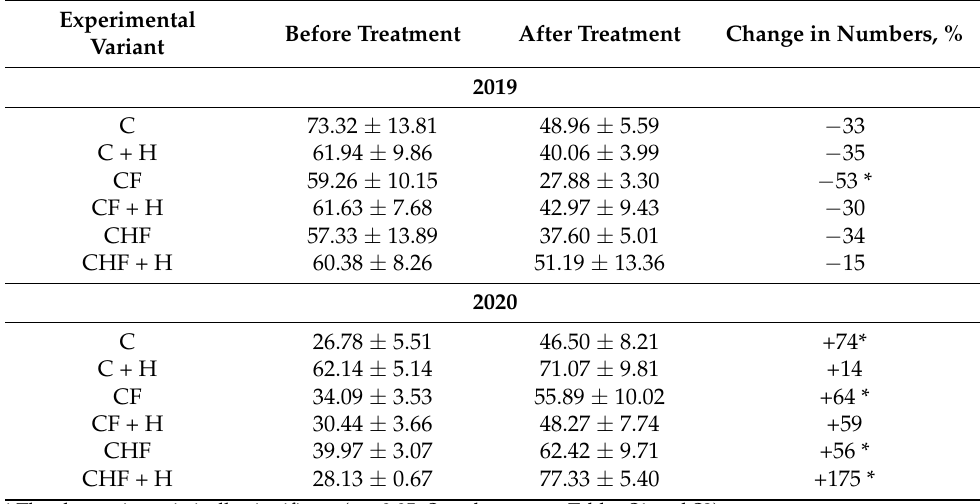
Table 7. The influence of a humic preparation on the number of prototrophic bacteria in Calcic Chernozem under